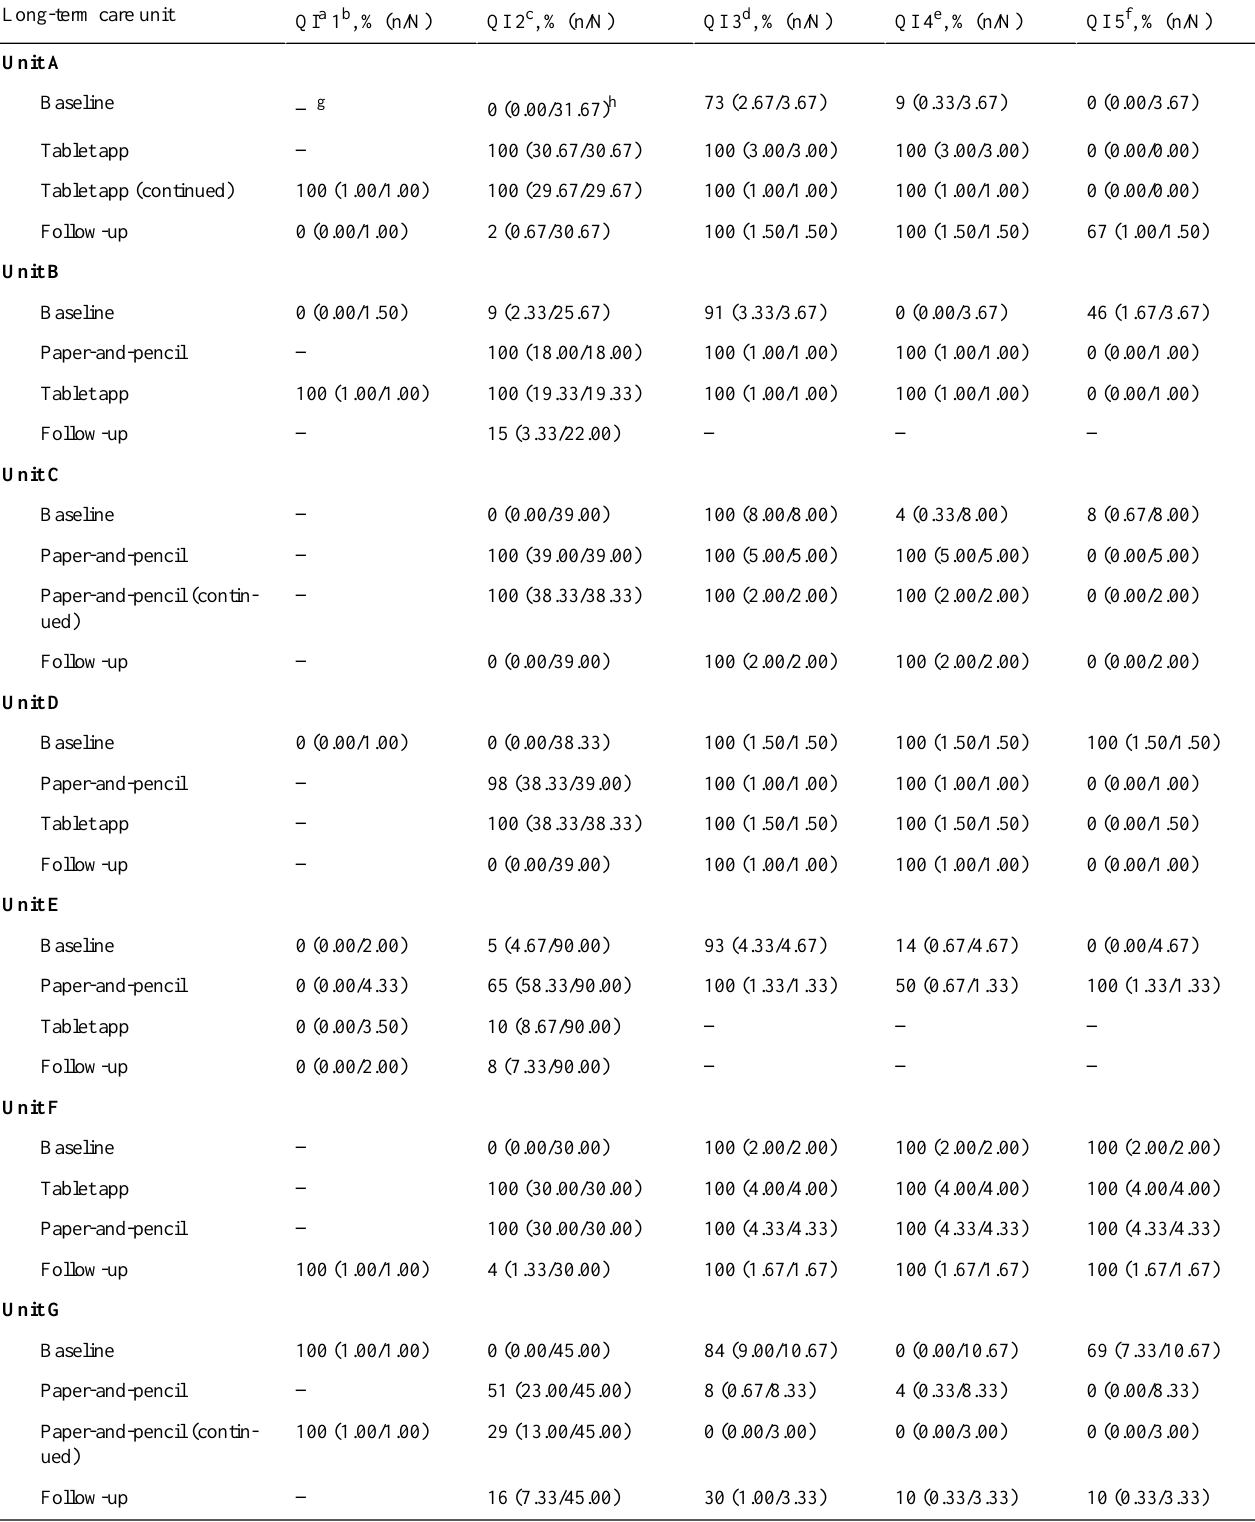
Table 1. Quality indicators from baseline, implementation, and follow-up periods averaged across the 3 weeks from each